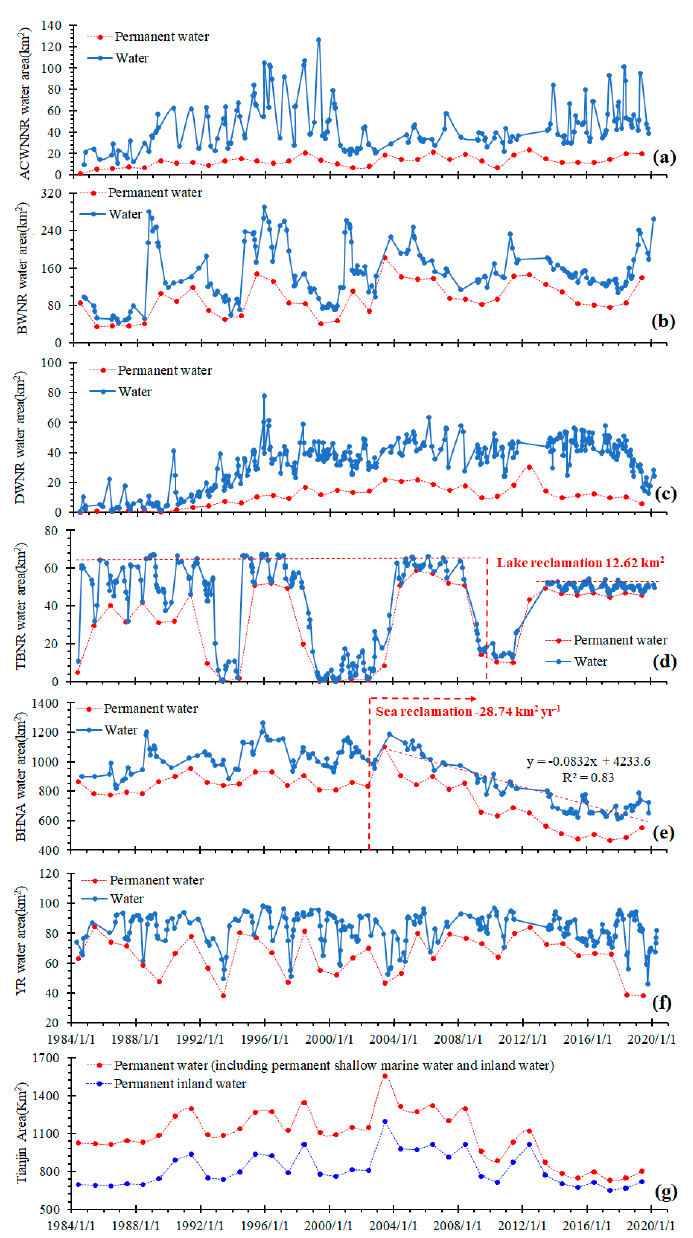
Figure 6. Long-term water area (blue dots) and permanent water area (red dots) changes for ACWNNR ( a ), BWNR ( b ), DWNR ( c ), TBNR ( d ), BHNA ( e ), YR ( f ) and Tianjin ( g ) during 1984–2019. The permanent water refers to pixels which were water for the duration of a calendar year. Note that the vertical dashed red lines represent the year when large area of land reclamation activities begins. The horizontal dashed red line in ( d ) represents mean largest water area before and after 2009. The oblique dashed red line in ( e ) represents the regression line for the water area after 2003.